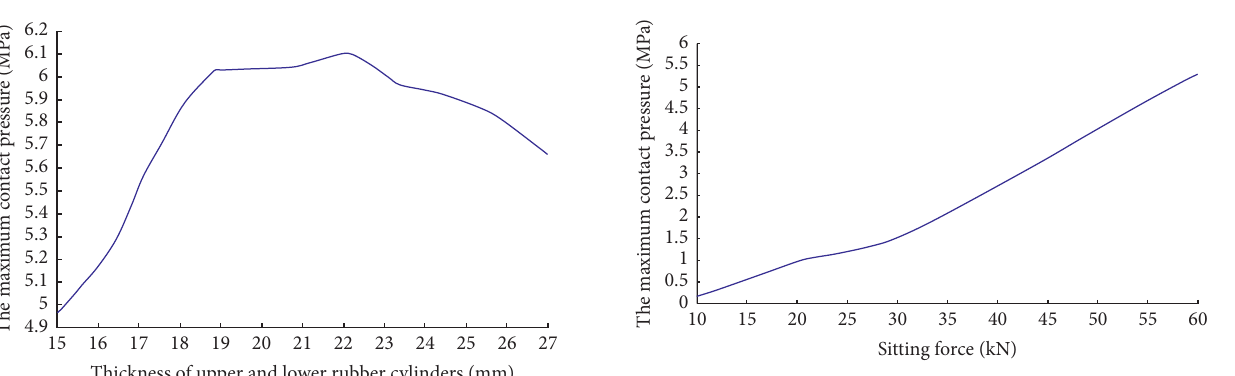
Figure 18: The maximum contact pressure curve of the rubber cylinder under different loads.